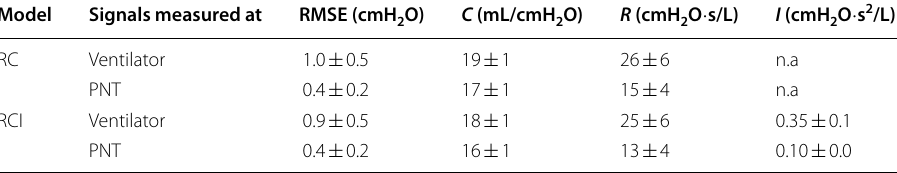
Values are mean standard deviation from 80 cycles during an inspiratory flow ramp down trial with flow values at 40, 35, ± 30,…, 20, 15 L/min, tidal volume of 244 ml, I:E 1:1 and respiratory rate set to 15 min − 1 . Compliance ( C ), resistance ( R ) and = inertance ( I ) as determined based on signals acquired at the ventilator and the pneumotachograph (PNT) using a two‑ (RC) and a three‑compartmental model